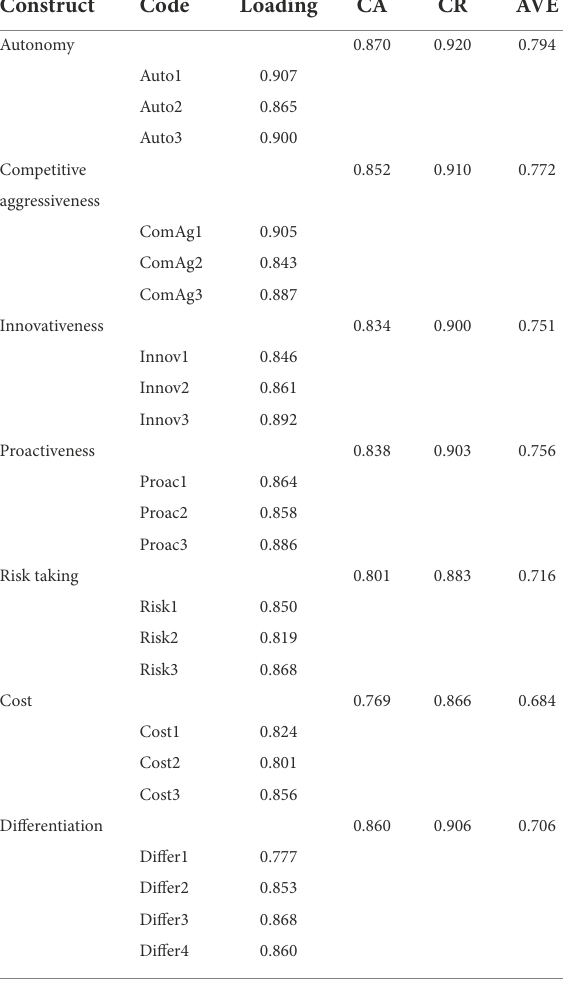
TABLE 4 Fornell–Larcker criterion.